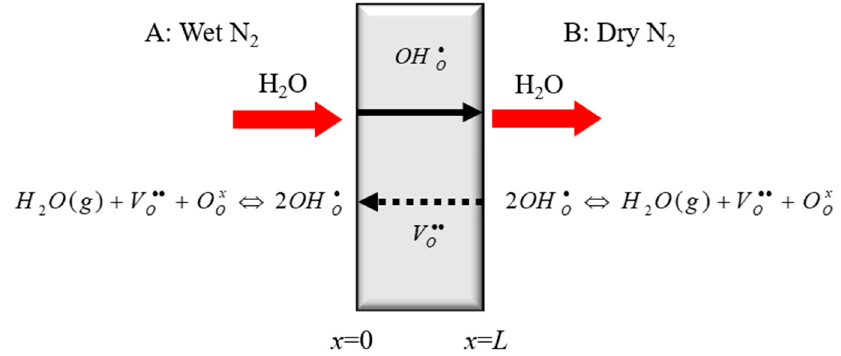
Figure 1. Schematic illustration of BCY10 membrane for modeling (L = membrane thickness).